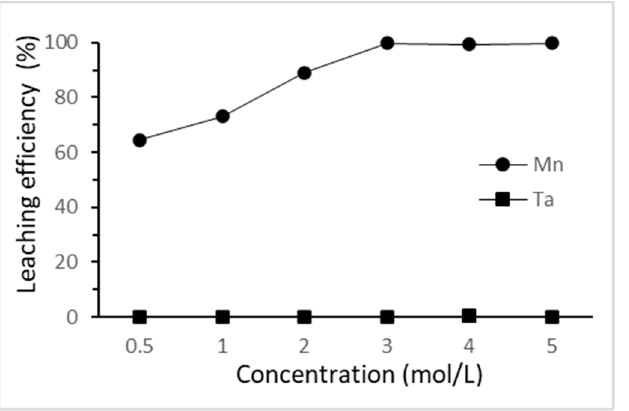
Figure 4. Effect of HCl concentration on the selective leaching efficiency. (L/S ratio: 50 mL/g; reaction time: 3 h; reaction temperature: 25 °C).